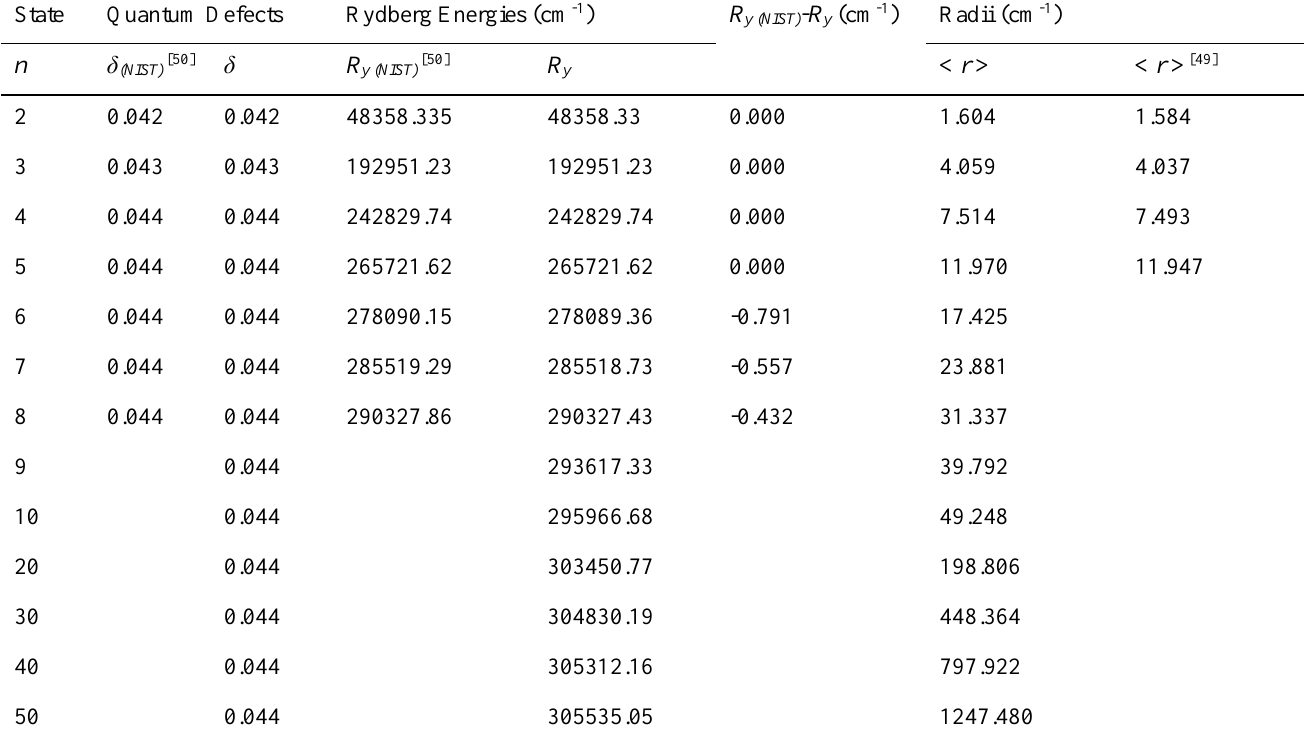
Spectral Rydberg Energy Series with Quantum Defects and Radii of Li iso-electronic sequence in 1 s 2 np 2 P o 1/2 (B III)